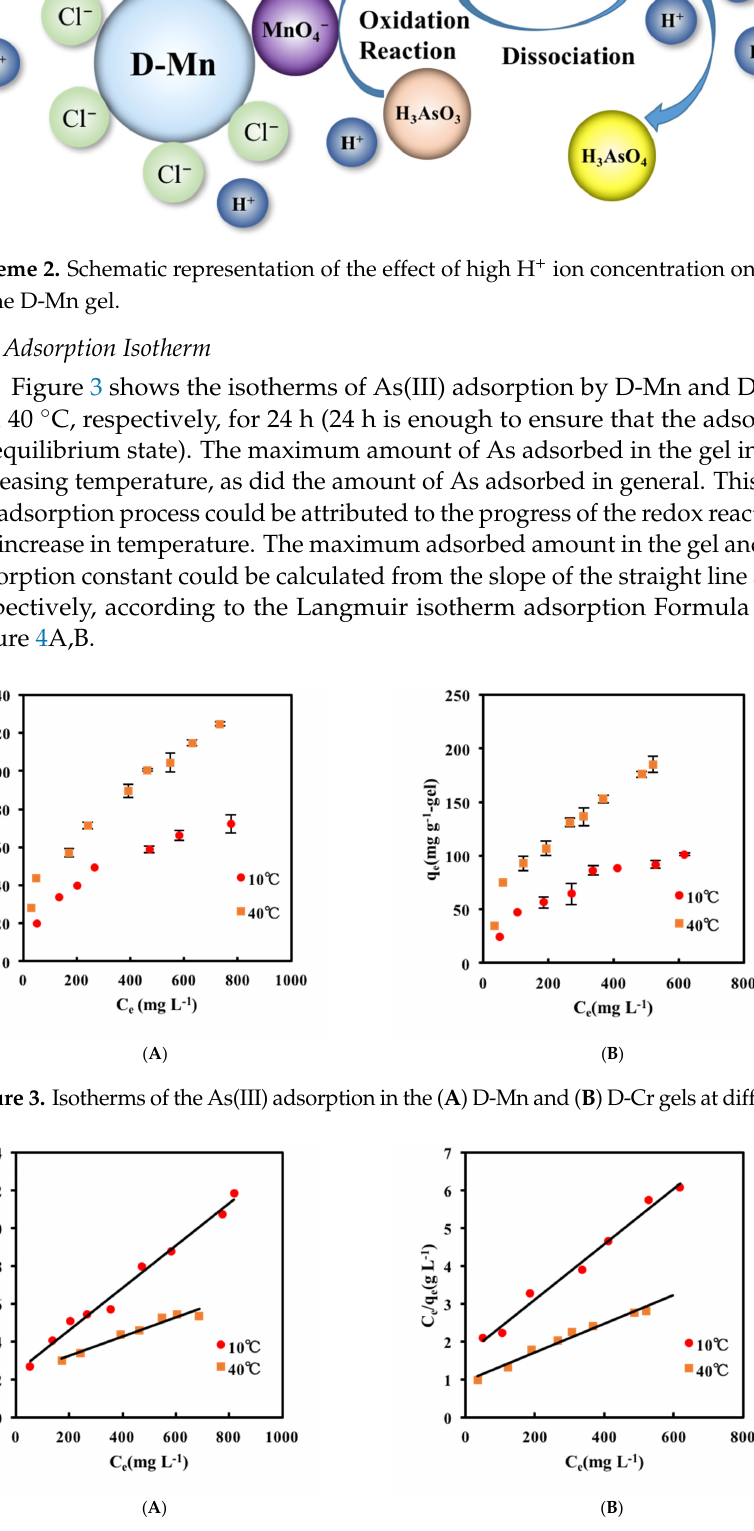
Figure 4. Langmuir isotherm plots for the As(III) adsorption in ( A ) D-Mn and ( B ) D-Cr gels at different temperatures. Table 1. Langmuir model parameters for As(III) adsorption in D-Mn gel.